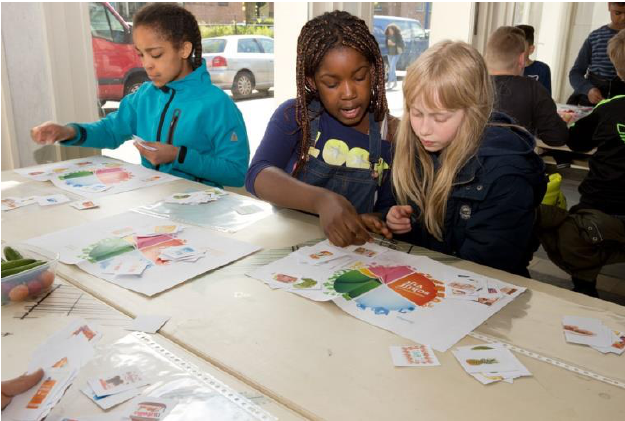
Figure 9. Playing with and placing products on a poster.